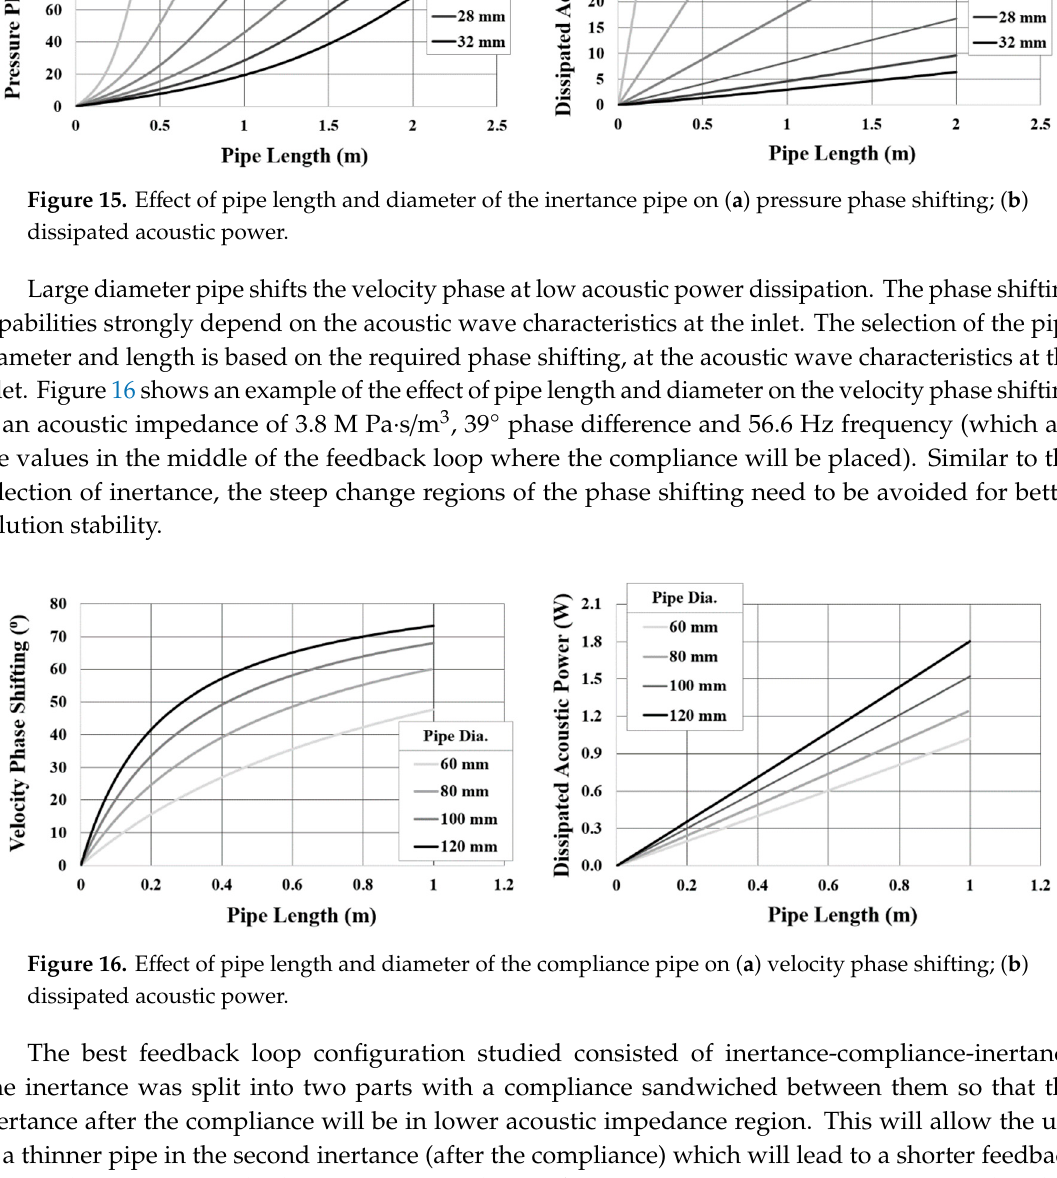
Figure 16. Effect of pipe length and diameter of the compliance pipe on ( a ) velocity phase shifting; ( b ) dissipated acoustic dissipated acoustic power.